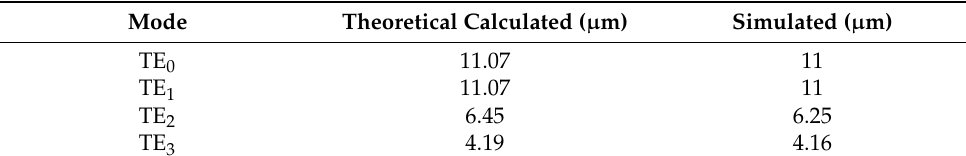
Table 2. Theoretical calculated and simulated waveguide length period.